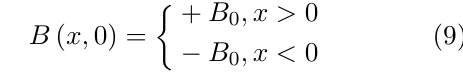
Figure 1. Schematic presentation of magnetic field with straight lines